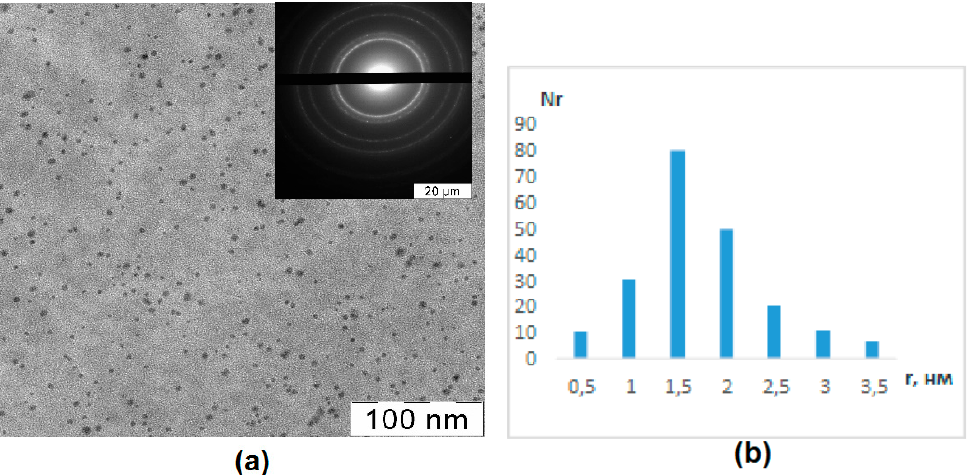
Figure 6. TEM pictures and electronic diffraction of the samples, including silver nanoparticles that are stabilized in a mesogenic 4-cyano-4 ′ -pentylbiphenyl matrix at 200 К ( a ) and a histogram of their size distribution ( b ).